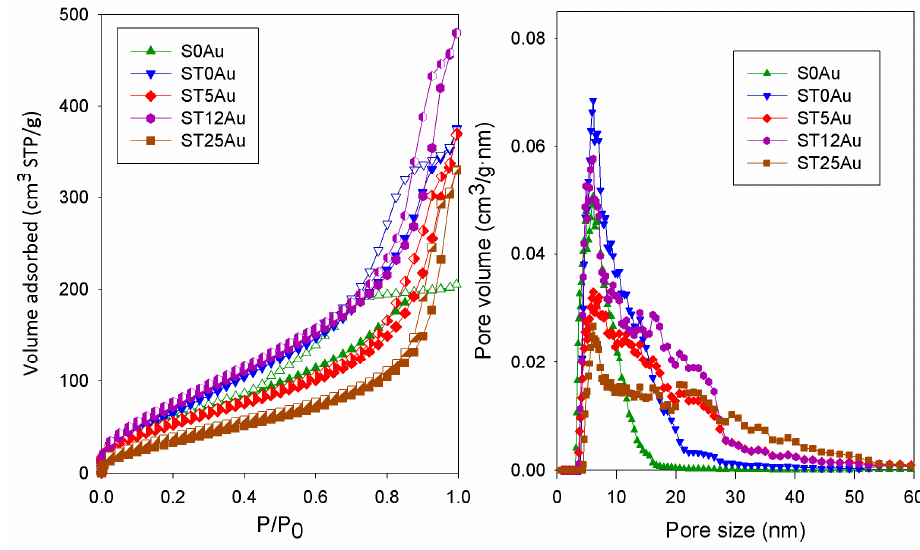
Figure 3. Isotherms and NLDFT (non-local density functional theory) pore size distributions obtained for the photocatalysts under study.